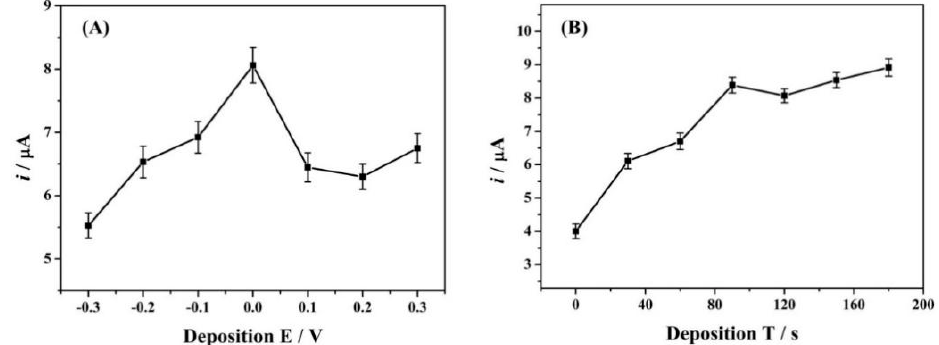
Figure 7. ( A ) Deposition potential and ( B ) deposition time on the oxidation peak currents of 10 µ M oxytetracycline (0.1 M PBS, pH = 6.5) at Ta 2 O 5 -ErGO/GCE.